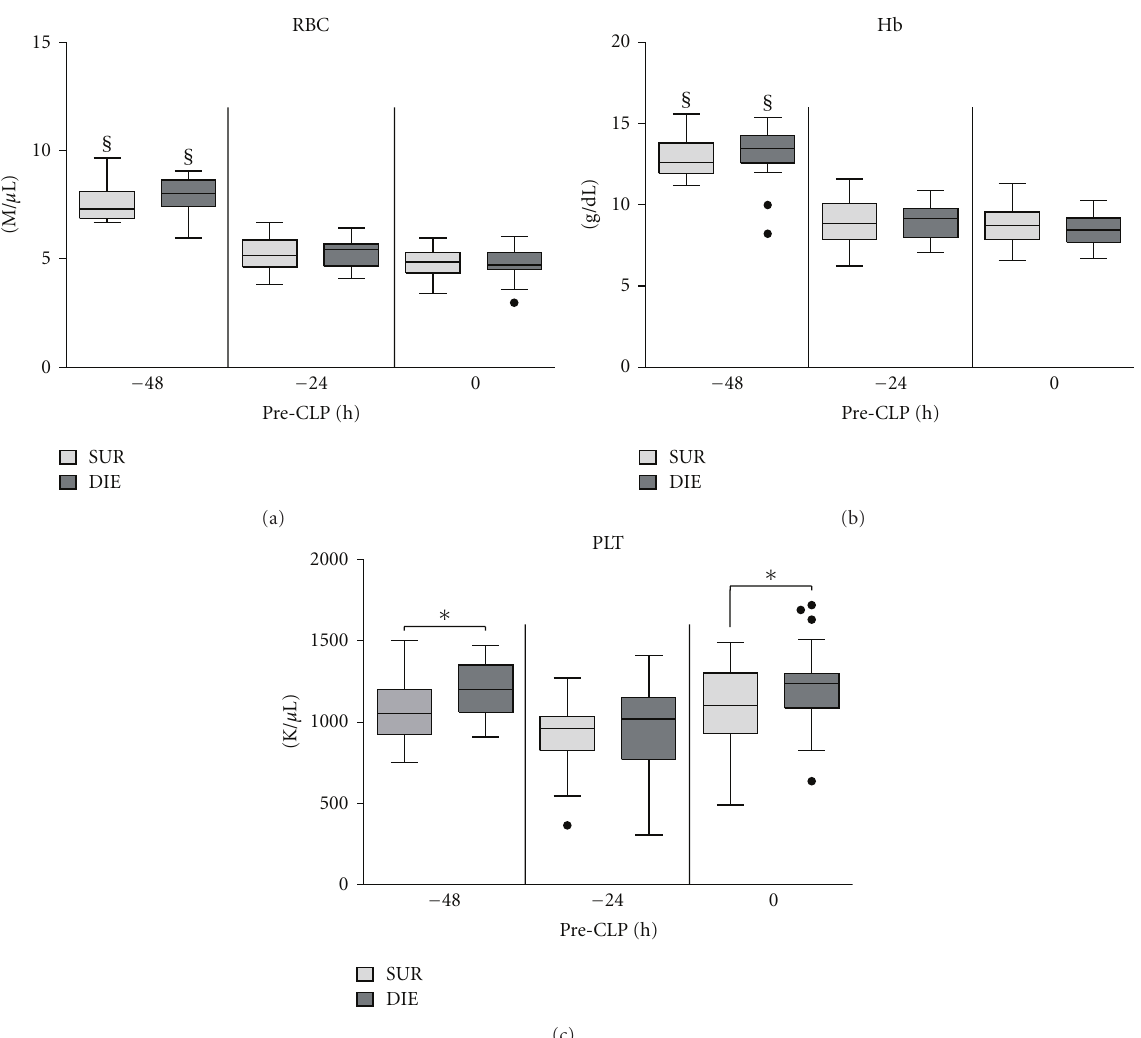
Figure 3: Retrospective comparison of red blood cell, platelet count, and hemoglobin concentration in dying (DIE) versus surviving (SUR) animals prior to CLP. 3-month-old female mice were subjected to trauma/hemorrhage prior to CLP. Displayed values were compared between DIE and SUR at − 48h (DIE at least n = 17, SUR at least n = 18), − 24 h (DIE at least n = 28, SUR n = 32), 0h before-CLP (DIE at least n = 28, SUR n = 32 for all parameters) and between time points. Dots represent outlayers. § P < . 05 between time points, and ∗ P < . 05 between DIE and